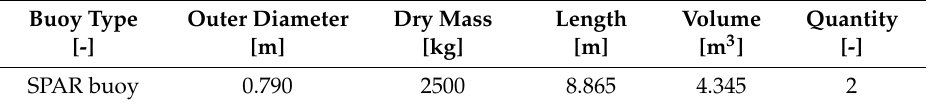
Table 2. Buoy properties.